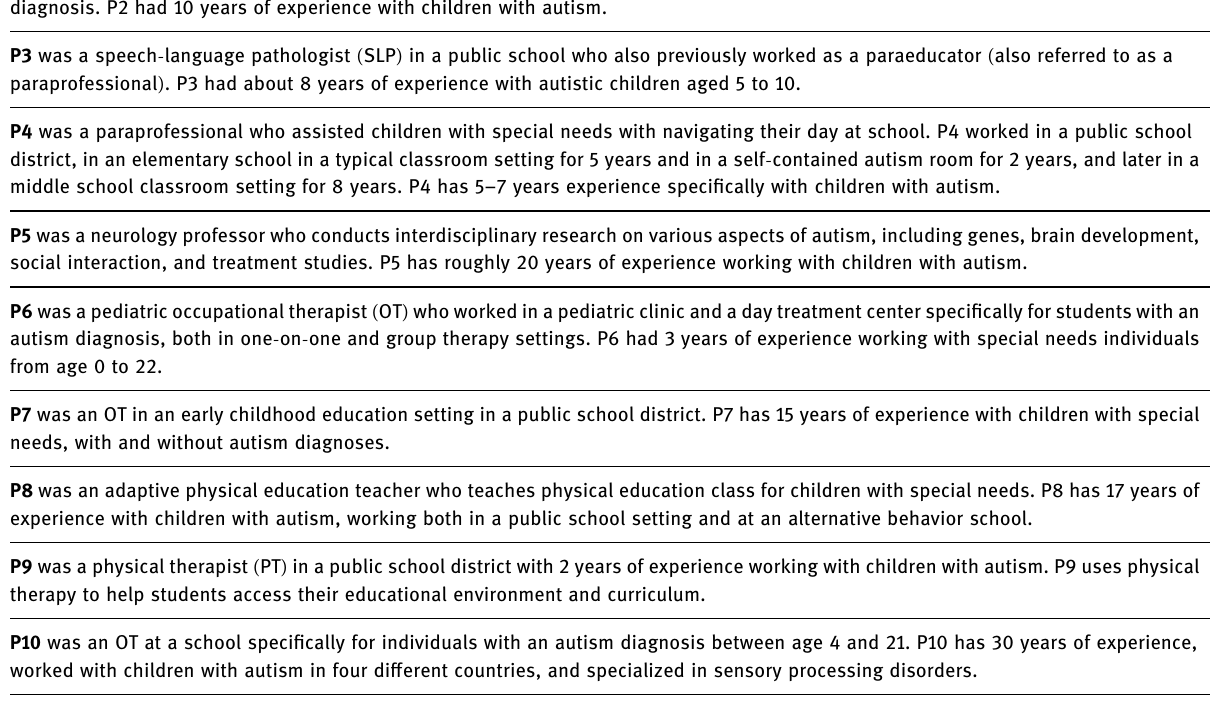
Table 2: Summary of participant experience and